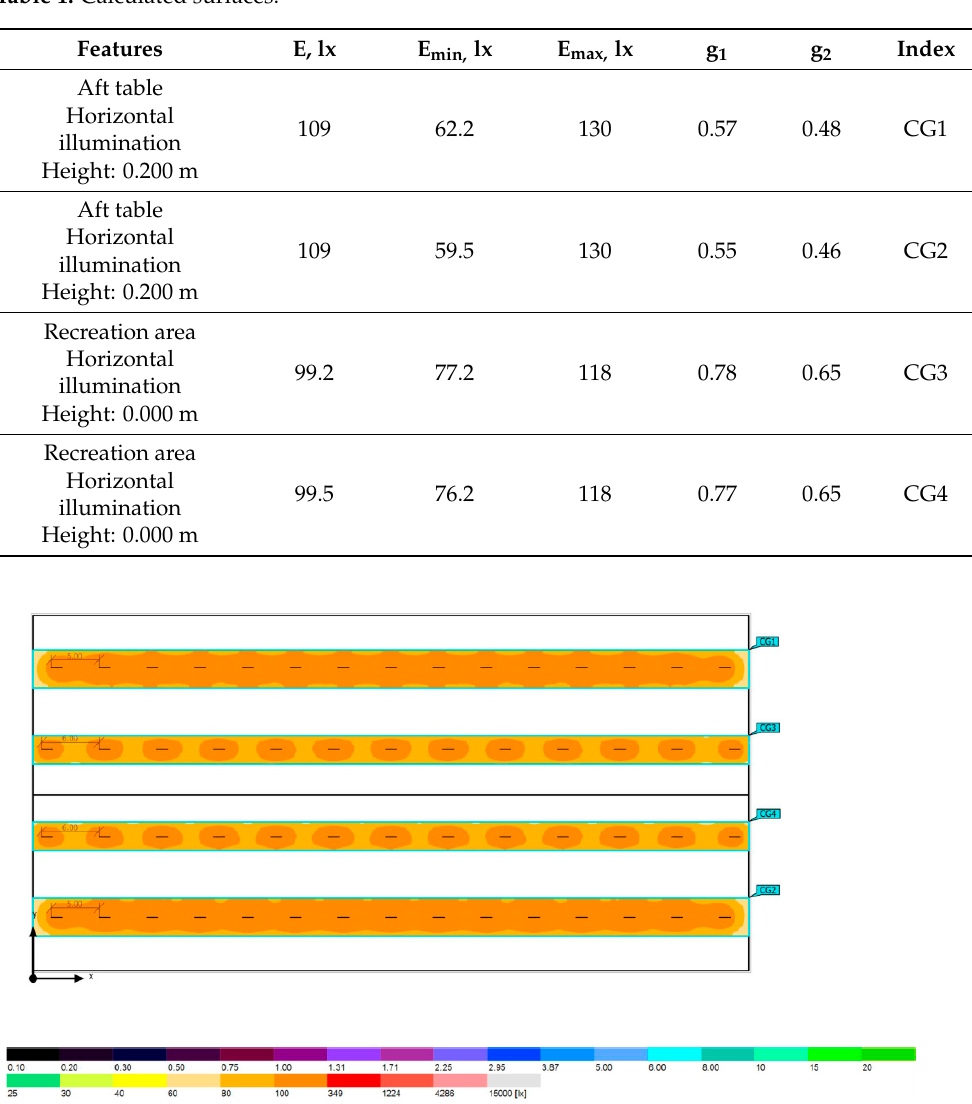
Figure 6. Calculated illumination values in the program applied in the cowshed depending on the height of the considered surface.